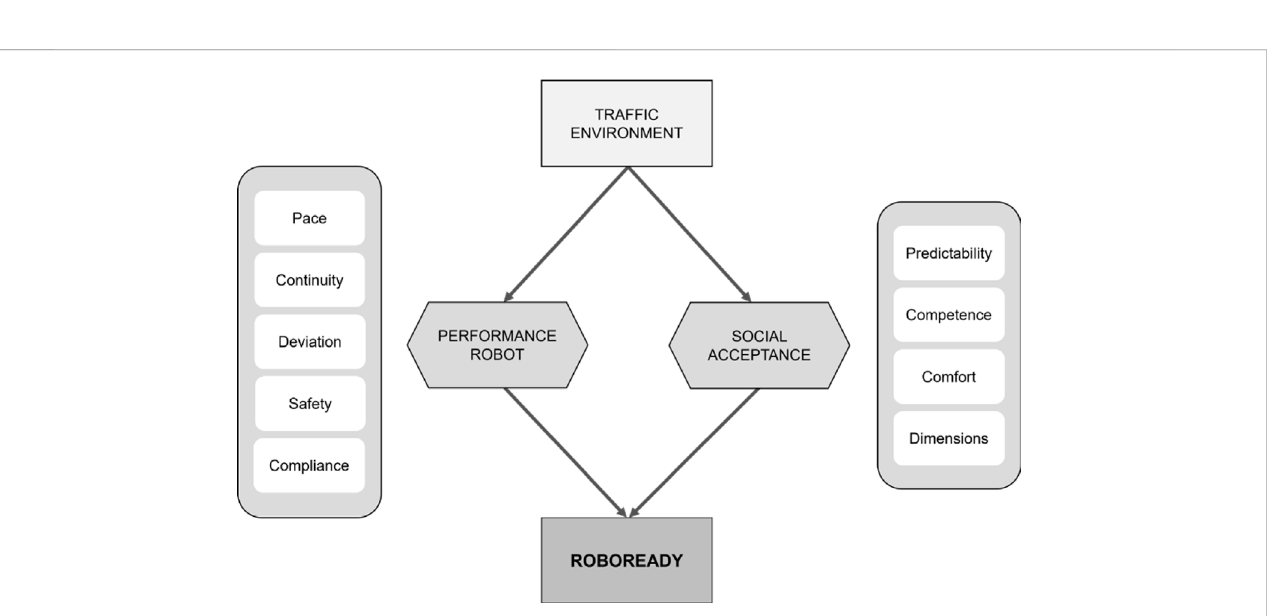
FIGURE 2 Conceptual model of the factors in fl uencing the